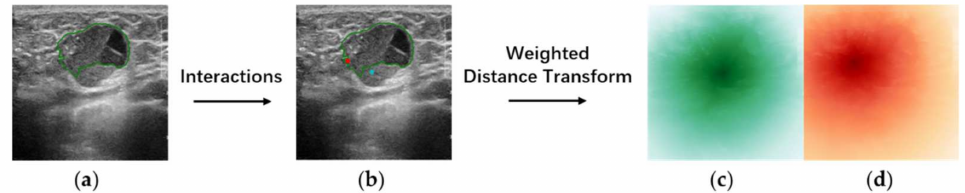
Figure 4. The process of getting interaction points in the testing phase. ( a ) The input image with the initial segmentation (green line); ( b ) the foreground point (cyan) and background point (red) given by the user interaction; ( c ) the foreground point distance map; ( d ) the background point distance